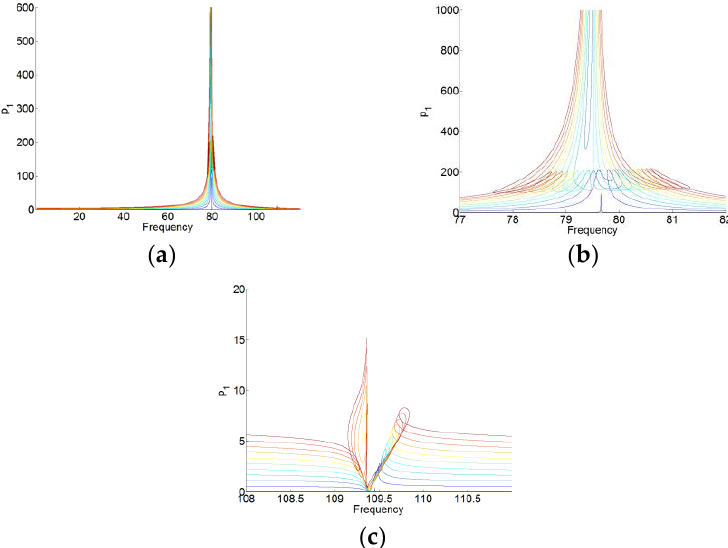
Figure 11. ( a ) Responses of p 1 ( t ) for F 1 = [ 0.01 : 2 : 20.01 ] . ( b , c ) are the zooms of ( a ) around two resonant frequencies of the cavity.